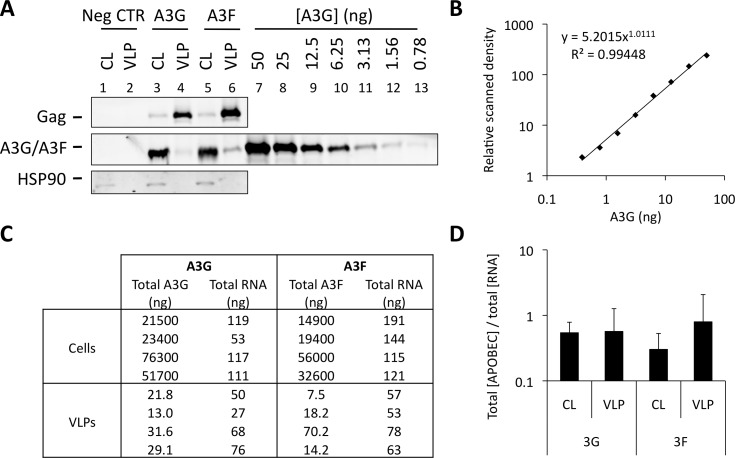
A3G and A3F concentrations are similarly distributed between cells and VLPs by RNA. (A)293T cells were co-transfected at a 1:5 ratio with expression vectors for T7-tagged A3G or A3F, and Wt Gag. Cell lysates (CL) were kept for analysis. Supernatant from cells transfected with an empty plasmid (negative control) and VLPs were harvested and isolated by ultracentrifugation through a continuous sucrose gradient (20–60%). Fractions were harvested and p24Gag-containing fractions were identified by immunoblot. T7-tagged A3G was purified and quantified as specified in the material and methods. Cell lysates, fractions containing VLPs (or the corresponding fraction from the negative control) and purified A3G were analysed by immunoblot. Gag and HSP90 were visualised using anti-p24Gag and anti-HSP90 antibodies, respectively. A3G and A3F were visualised using an anti-T7 antibody. APOBEC3 proteins were quantified by densiometry. This figure shows a representative example. (B) Standard curve of purified T7-A3G visualised and quantified by densiometry of the immunoblot of Fig. 7A. (C) RNA was extracted from cell lysates (CL) and VLP samples and quantified. Total A3G/F protein in CL and VLPs was quantified using a standard curve. The RNA in the negative control was below the detection threshold of the method. (D) The total amount of A3G or A3F was divided by the total concentration of extracted RNA. The graph shows the average of 4 independent experiments. Error bars indicate standard deviation. There was no statistically significant difference between the ratios in lysates and VLPs (p>0.5).